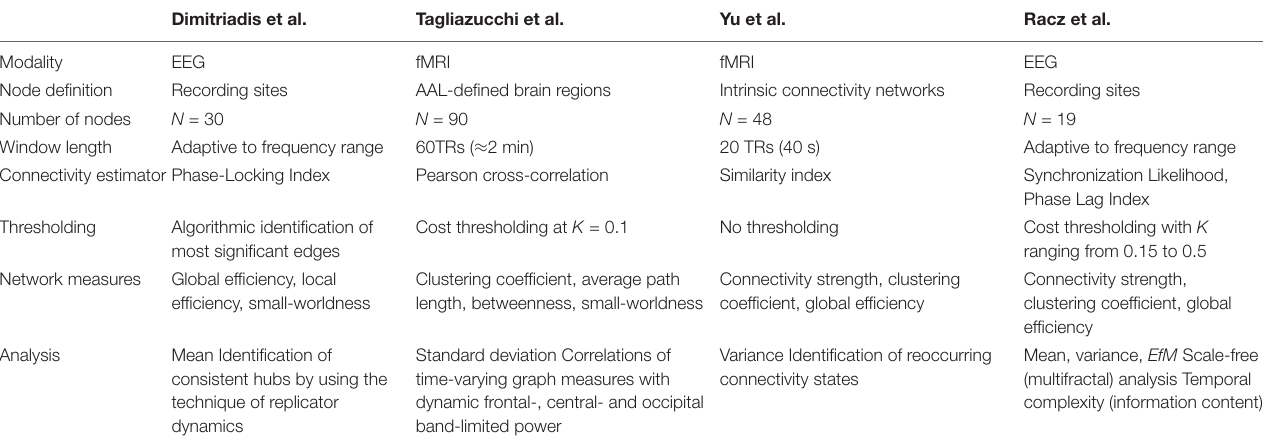
TABLE 7 | Comparison of various DFC approaches based on dynamic graph-theoretical